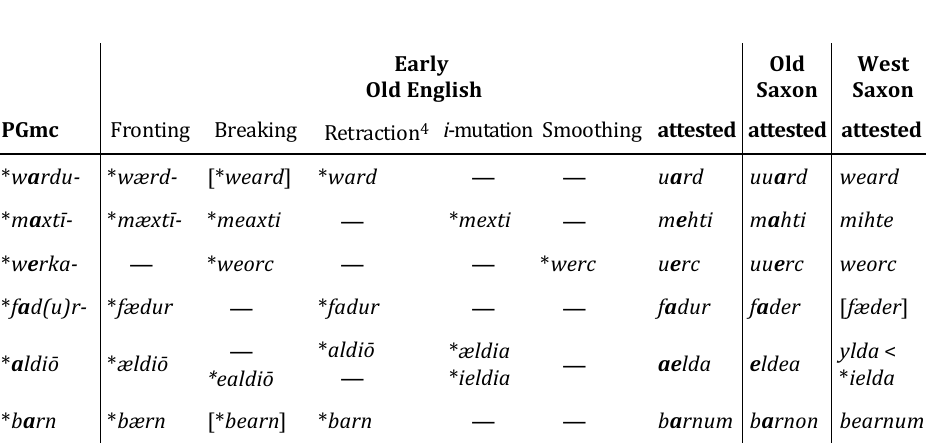
Table 4 : Sound laws of Pre-Old English according to the Standard